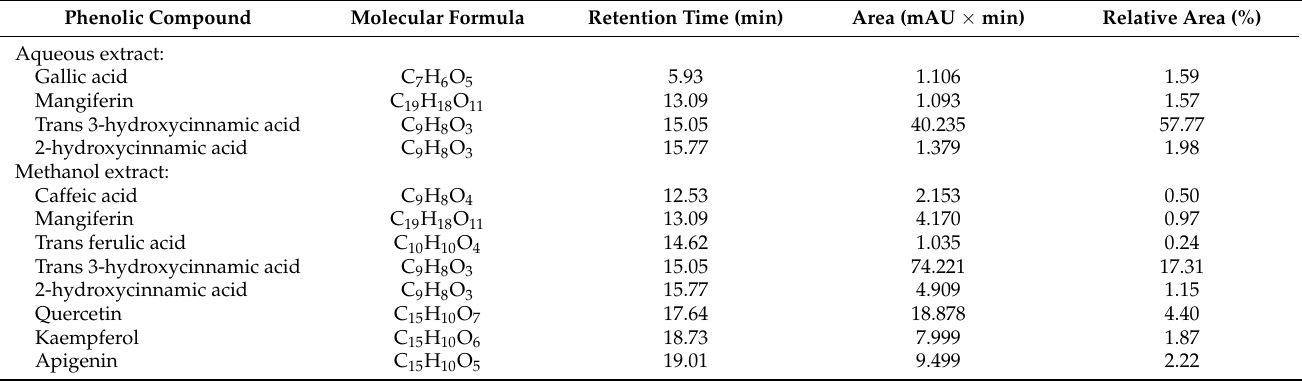
Table 2. Contents of phenolic compounds in the aqueous and methanol extracts of bee bread. Phenolic